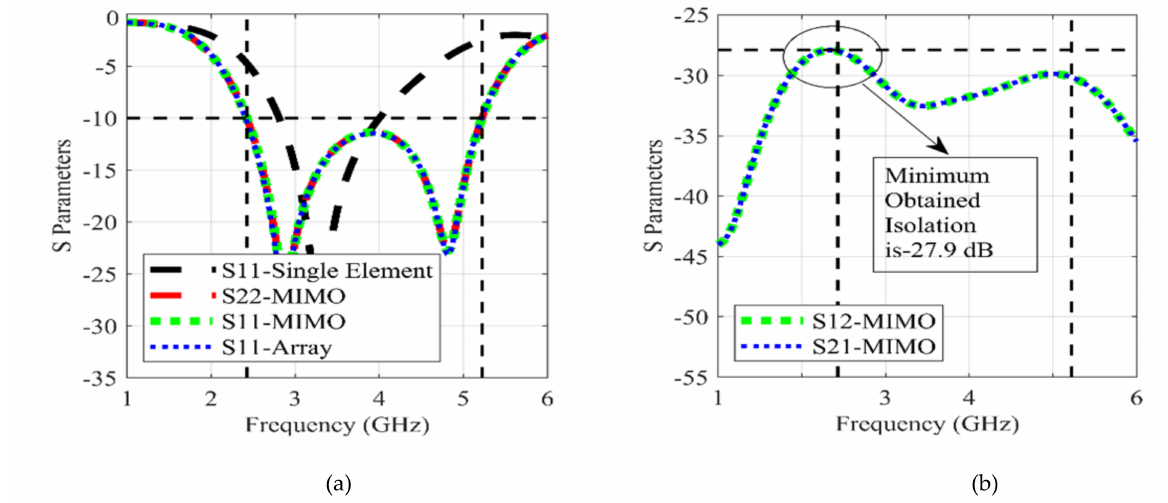
Figure 4. Scattering parameters for the mid-band (4G LTE and lower 5G) antenna design: ( a ) reflection; ( b )